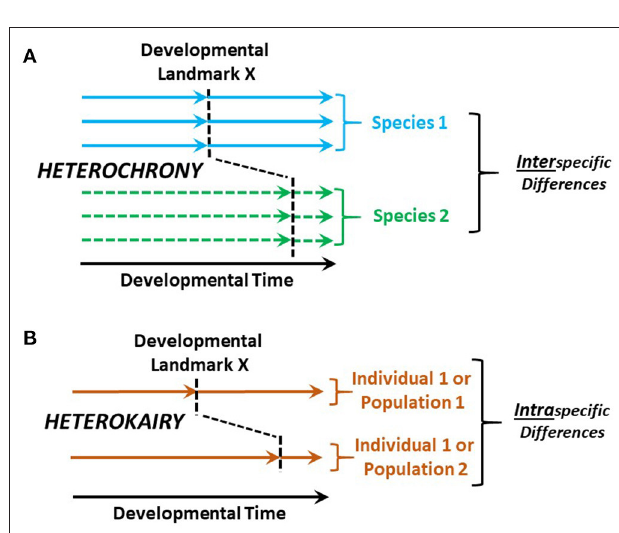
FIGURE 2 | Heterochrony compared with heterokairy. (A) Heterochrony compares the timing of developmental landmark between a species of interest and the ancestral species. (B) In contrast, heterokairy compares the developmental landmarks of two different individuals or populations within a single species. Typically, the developmental landmarks are anatomical—e.g., the appearance of gill arches, cardiac valves or nephrons. However, these concepts apply equally well to physiological developmental landmarks such as the onset of gill ventilation, the onset of anterograde blood flow through the heart, or the first production of